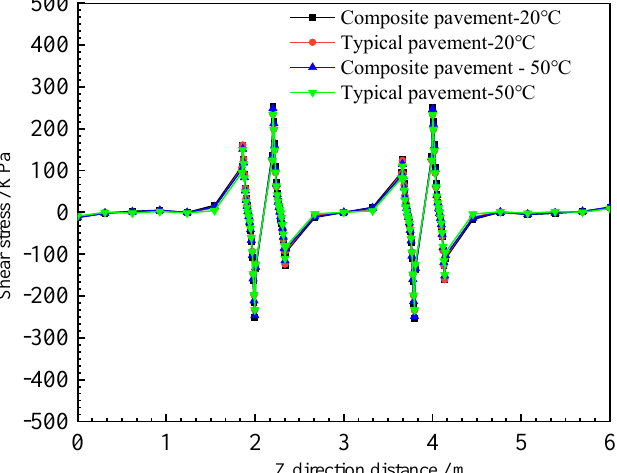
Figure 17. Upper-layer maximum shear stress.